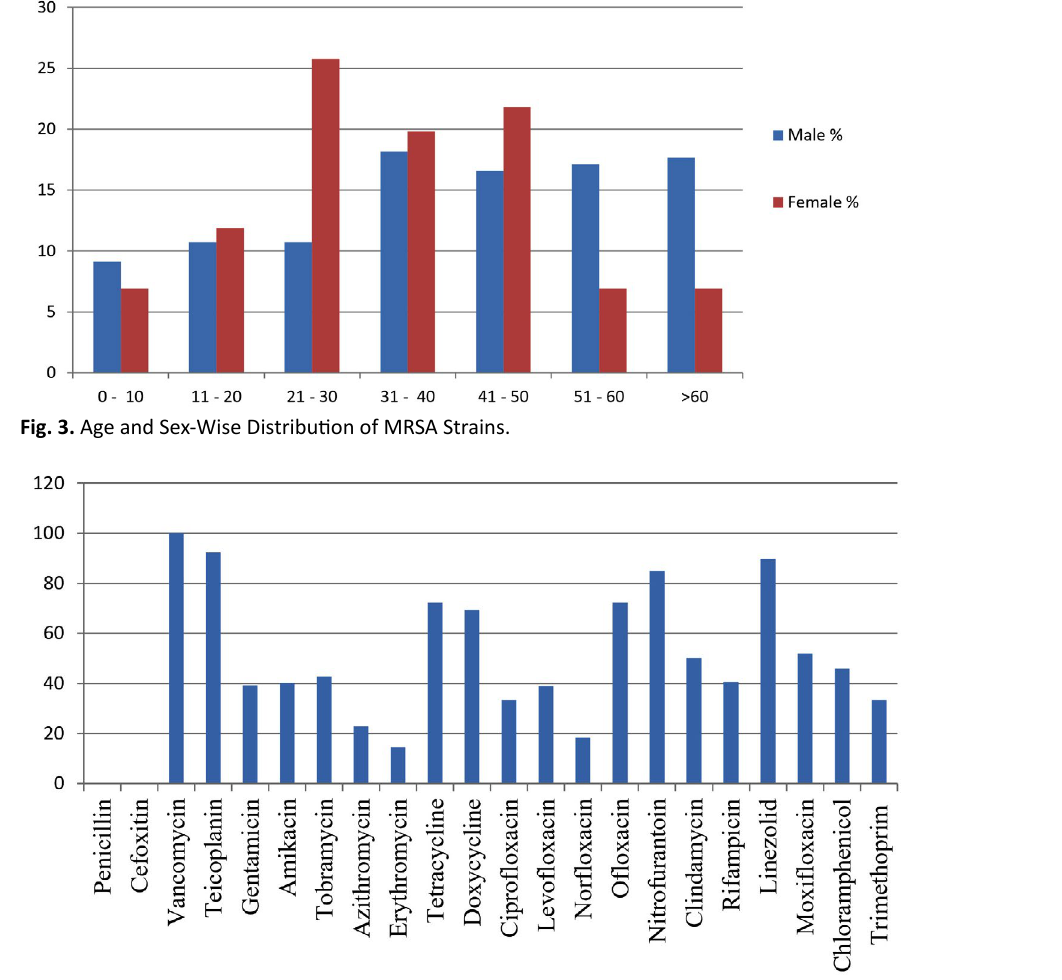
Fig. 4. Antibiotic Susceptibility Patterns of